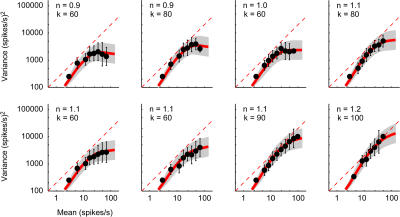
Relationship between Variance and Mean for Eight Cells Recorded Extracellularly in Cat V1, and Fits by the Gaussian–Rectification ModelFor each mean firing rate, data point and error bars indicate mean ± 1 s.d. of the observed variance. Red curves and shaded areas are predictions of the model. Values of exponent n and gain k are reported next to each graph. Cells are arranged in order of increasing exponent n.